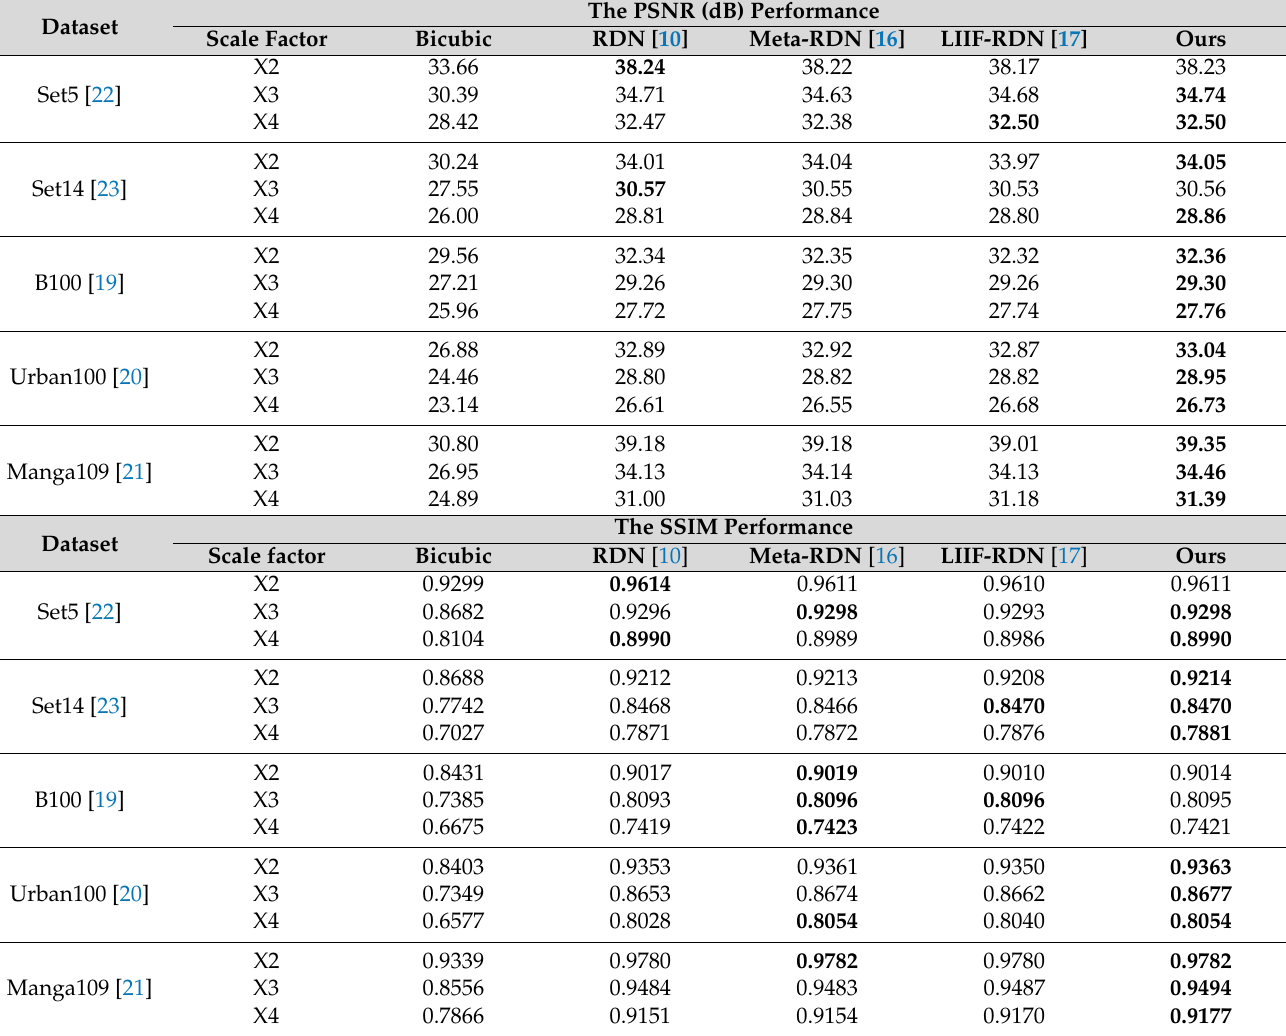
Table 5. The PSNR (dB) and SSIM performance comparison of various SR approaches. The best performance is highlighted in the bold